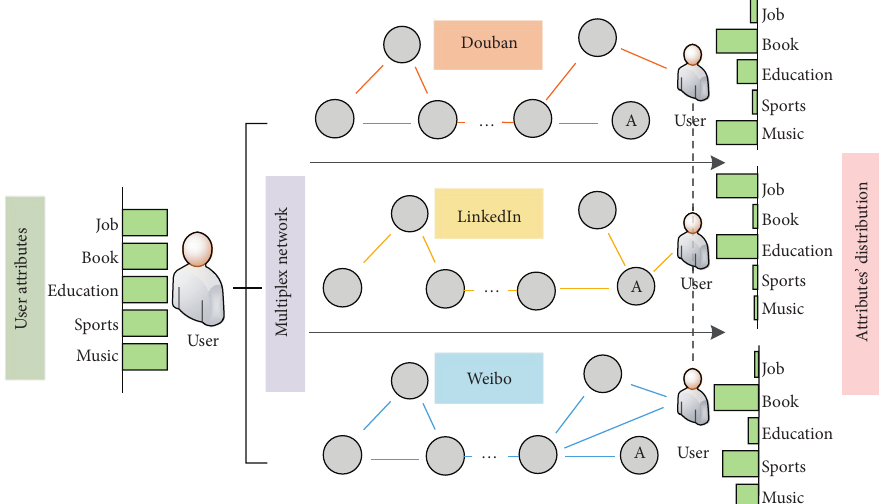
Figure 1: The illustration of our data structure and dependence between node attributes and each layer’s topology for three-layer multiplex networks as an example. The first part on the left presents node attributes. The second part on the middle indicates the multiplex network data model. The latter part shows the different dependence between node attributes and each